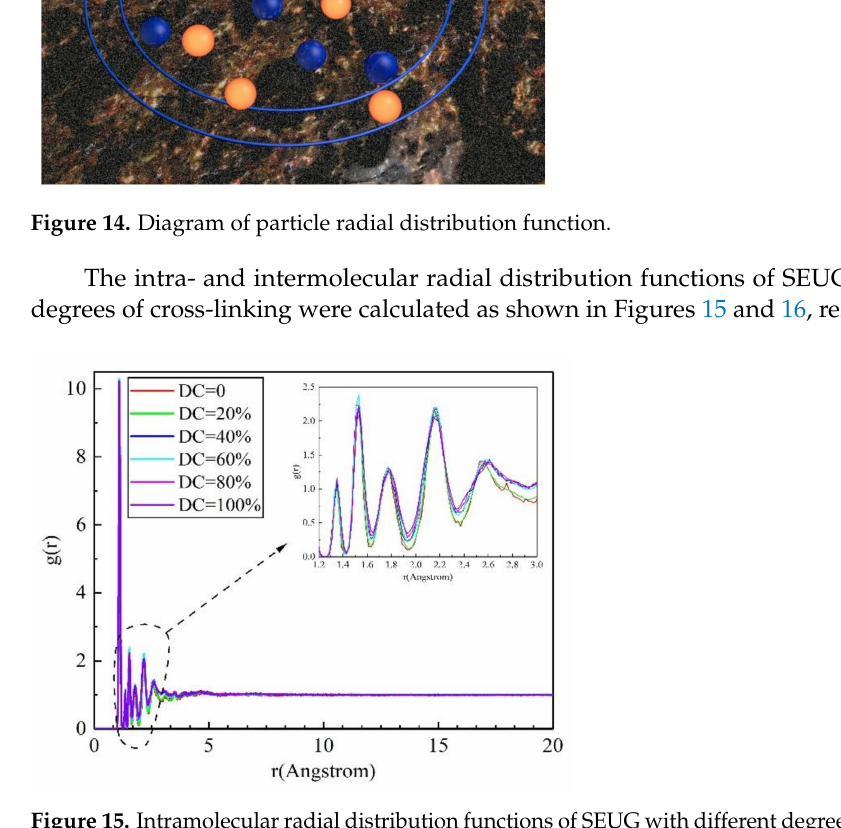
Figure 15. Intramolecular radial distribution functions of SEUG with different degrees of